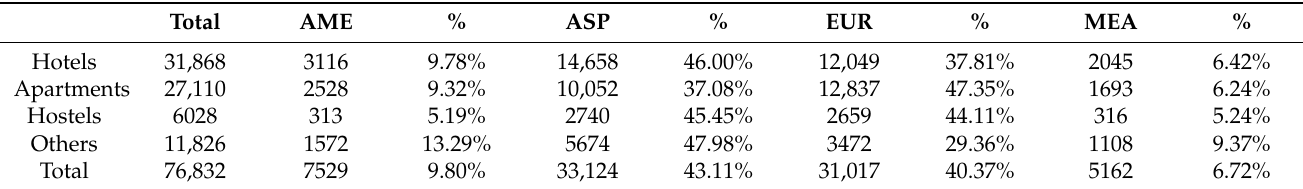
Table 1. Total accommodations available on Booking.com by regions (100 cities 6–7 April